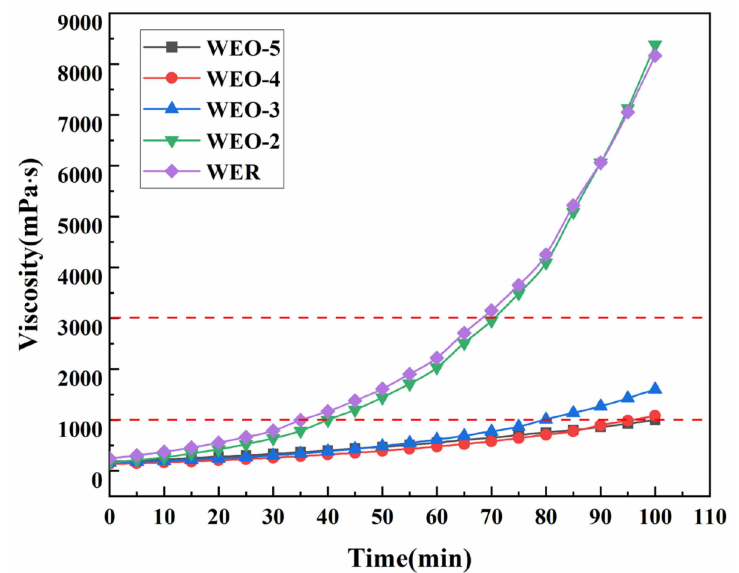
Figure 4. Viscosity of WER and WEO.